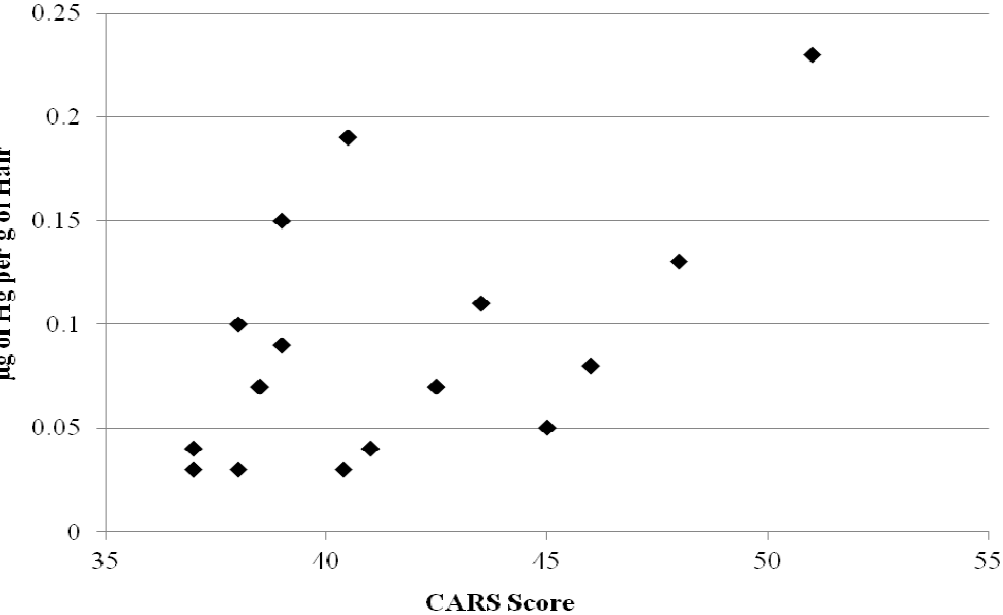
Figure 1. A summary of the scatter plot distribution of hair Hg concentrations in comparison to CARS scores. The scatter plot distribution excludes the highest anomalous hair Hg